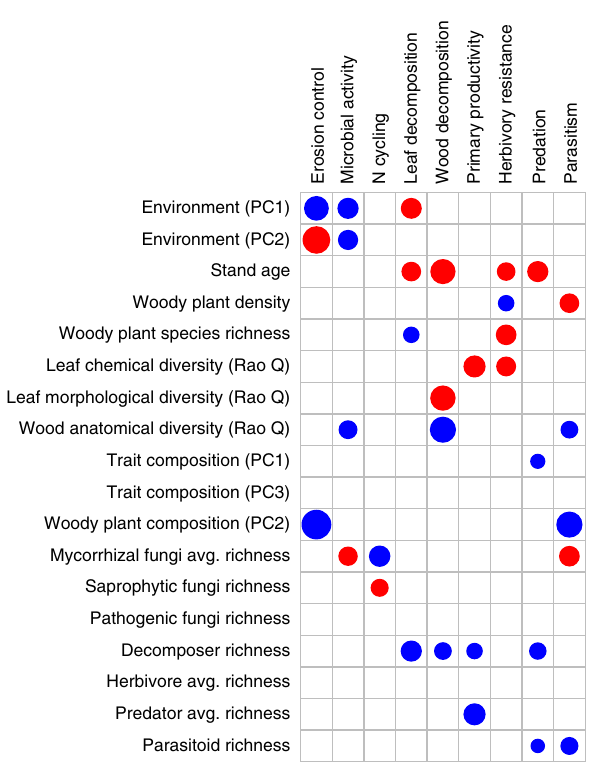
Fig. 5 Biodiversity effects on individual functions. Summary of the model- averaged effects (with a maximum of four predictors per individual model) of abiotic plot characteristics, woody plant diversity and composition, and heterotrophic species richness on nine ecosystem functions in a biodiverse subtropical forest. Blue and red circles indicate signi fi cant ( P ≤ 0.05) positive and negative effects, respectively, in the models shown in Supplementary Table 10 ( n = 26) (see also Supplementary Figs 8, 9). Circle size scales with the predictors ’ standardized estimate. avg.